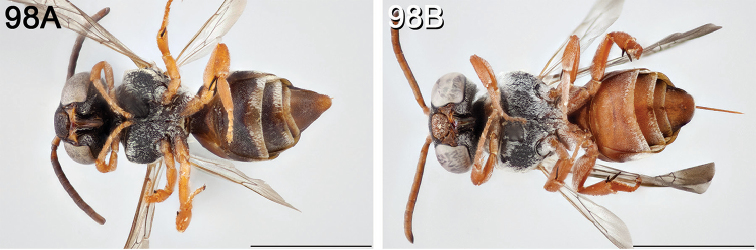
Female A
E.
pusillus, ventral habitus, showing color contrast between the dark brown antennae and metasomal sterna and the reddish-orange legs, and B
E.
basili paratype, ventral habitus, showing antennae, legs, and metasomal sterna with similar reddish-orange coloration.